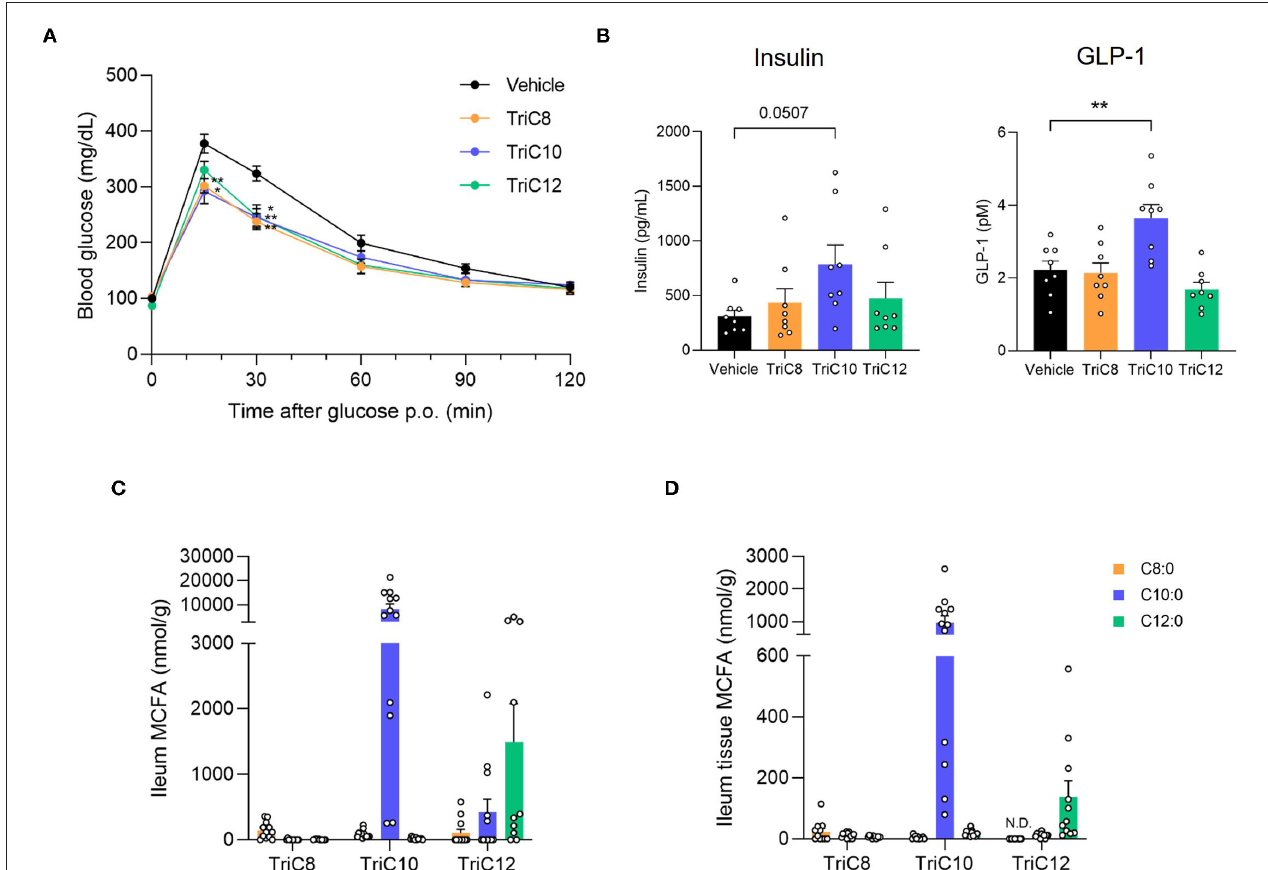
FIGURE 2 | Medium-chain triglyceride (MCT) administration enhances glucose tolerance. (A) Oral glucose tolerance test (OGTT) was performed at 1h post-MCT administration (2.4 g/kg body weight) ( n = 7). ** P < 0.01; * P < 0.05 (Tukey-Kramer test). (B) The plasma levels of insulin (left; n = 8–10) and GLP-1 (right; n = 8–10) at 1.5h after the oral administration of MCTs. ** P < 0.01 vs. vehicle control (Dunnett’s test). (C) and (D) Medium-chain fatty acid (MCFA) levels in ileal content (C) or tissue (D) of ileum at 1h after the oral administration of MCTs ( n = 10–12). The concentration of MCFAs were measured by liquid chromatography/mass